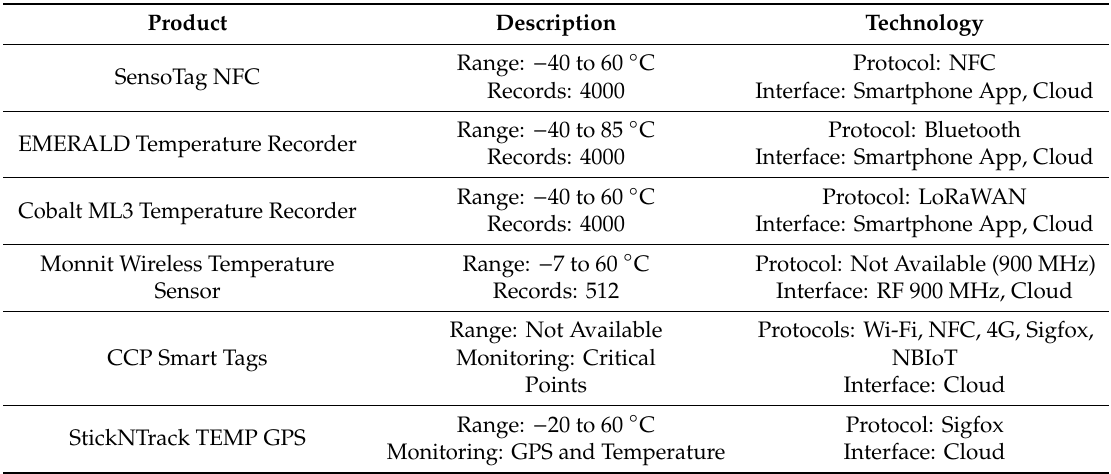
Table 1. Temperature tracking commercial